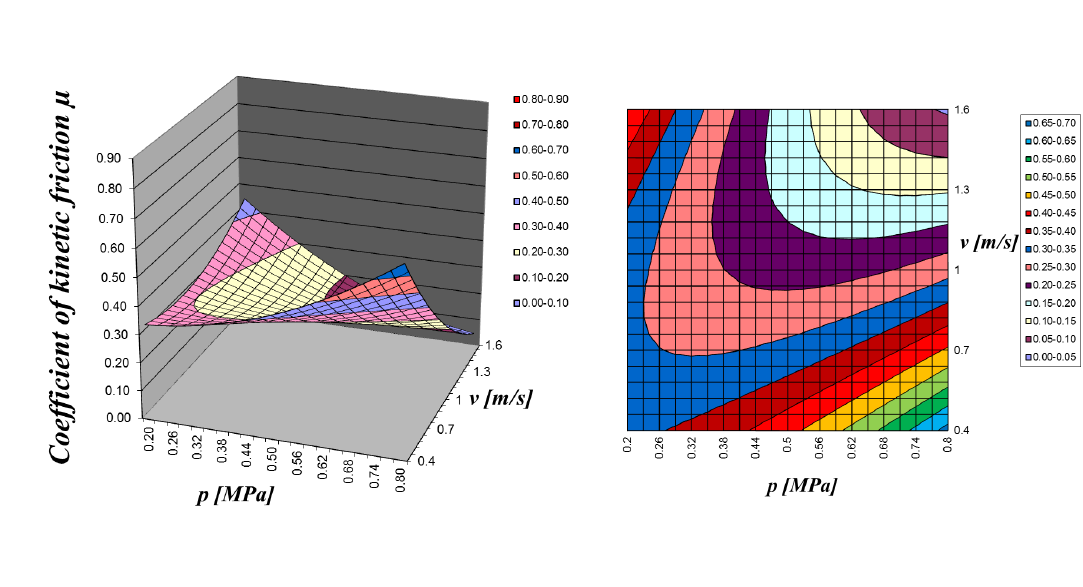
Figure 4: Coeflcient of friction of EPUR with hardness of 93 ∘ Sh A after steel dampened with water depending on the pressure p and sliding speed v Table 2: Coeflcients of the regression function and statistical evaluation of the designated